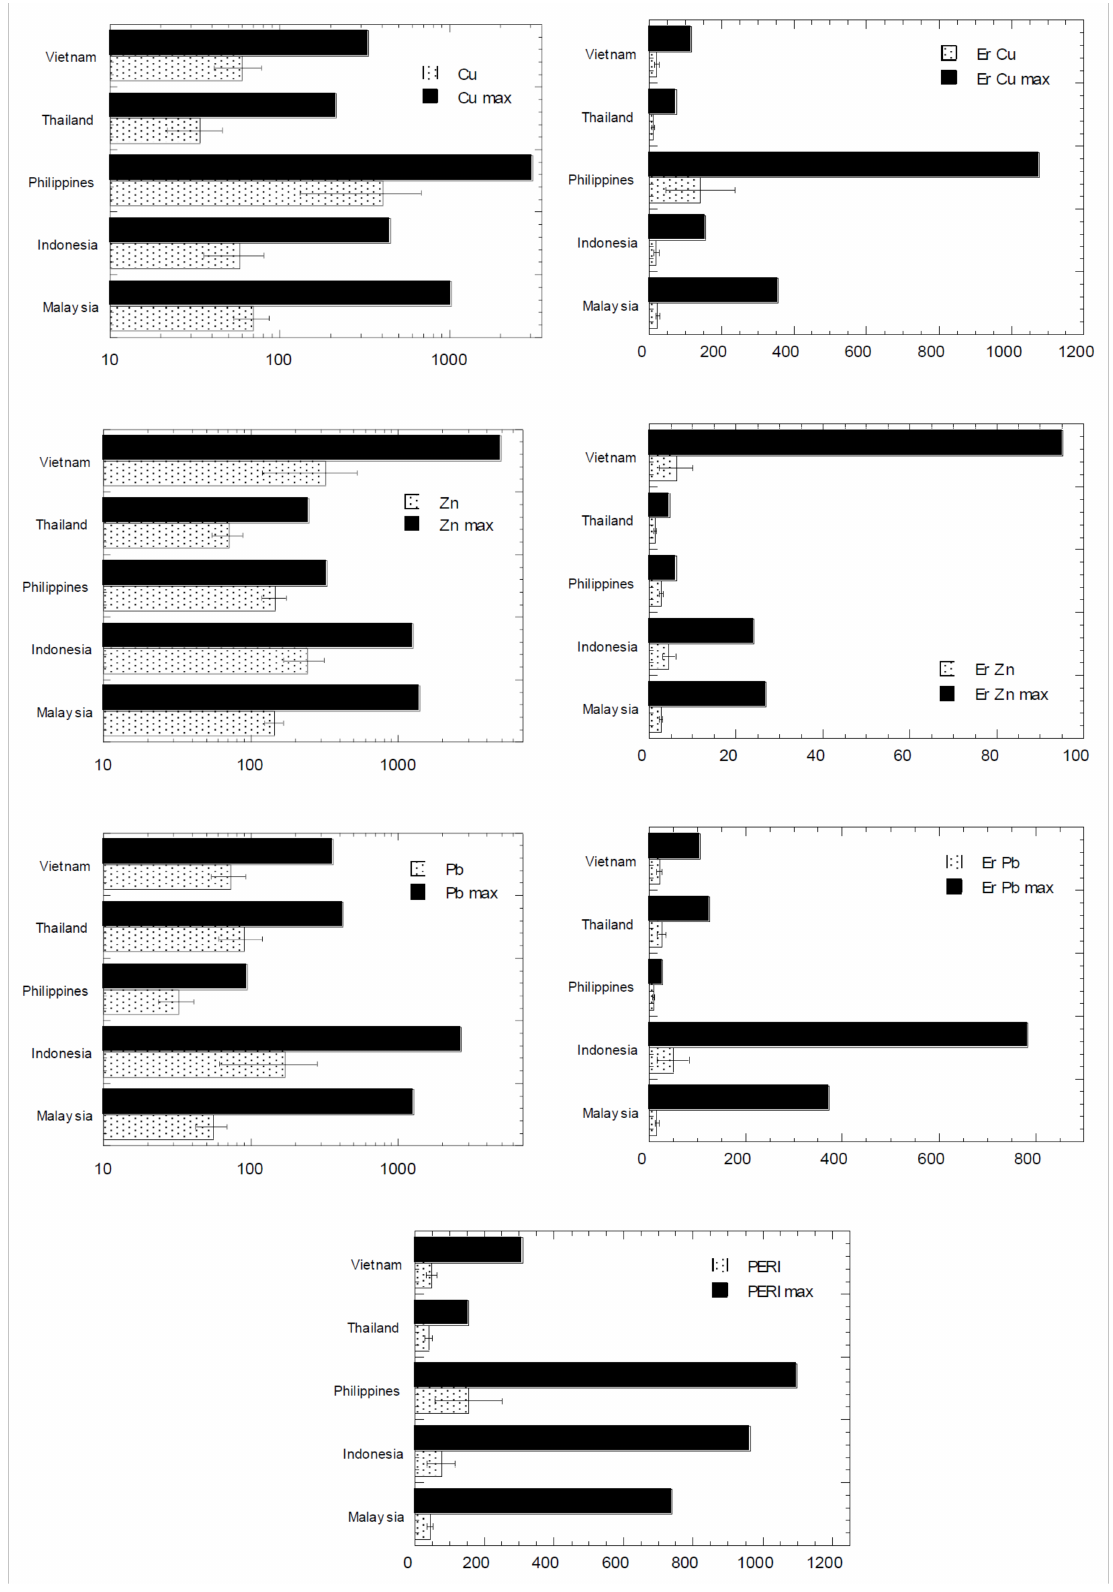
Figure 2. Overall statistics of values (mean ± SE, and maximum) of concentrations (mg/kg dry weight) of Cu, Zn, and Pb, and their ecological risks (Er) and potential ecological risk index from the ASEAN-5 countries in the present